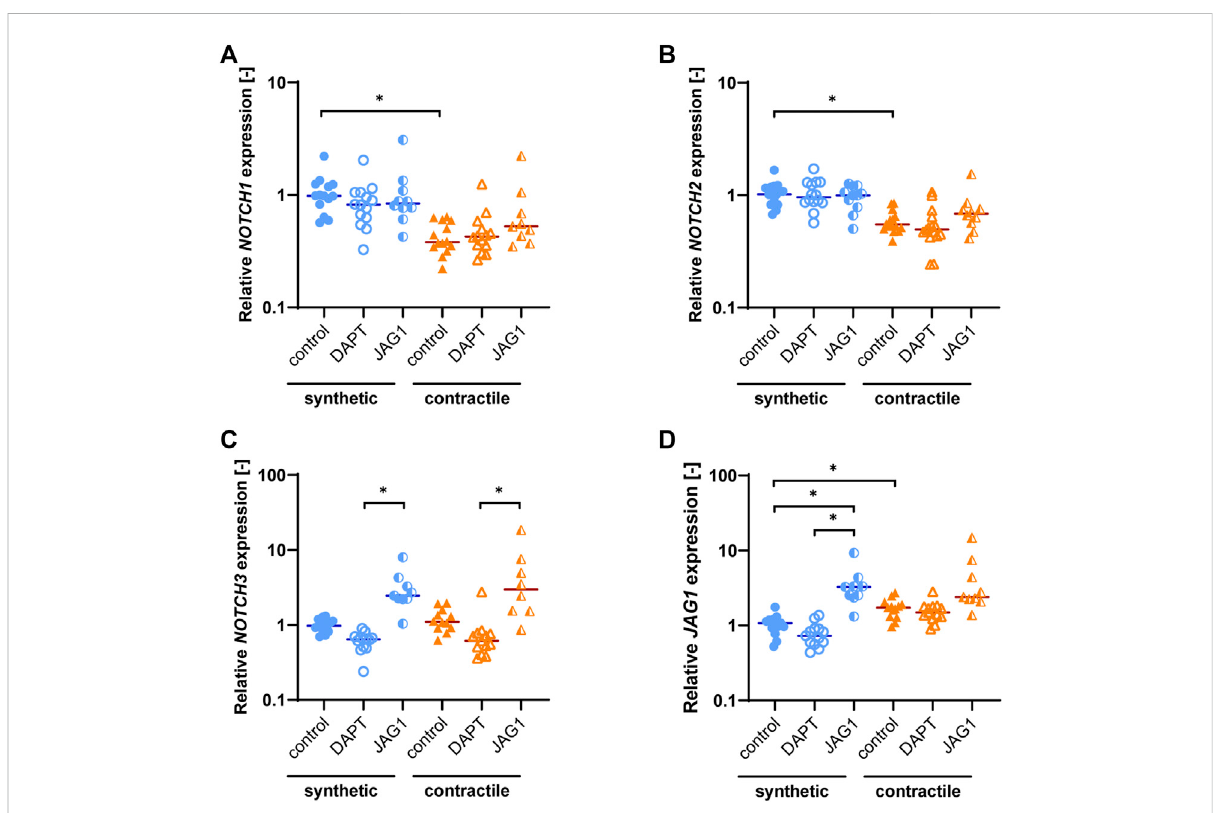
FIGURE 3 Notchpathway geneexpressioninsyntheticandcontractileVSMCs,andtheimpactofNotchsignalinhibitionandactivation onNotchpathway genes. Gene expression of Notch signaling components (A) NOTCH1 , (B) NOTCH2 , (C) NOTCH3 , (D) JAG1 , normalized to the synthetic control condition (* p < 0.05